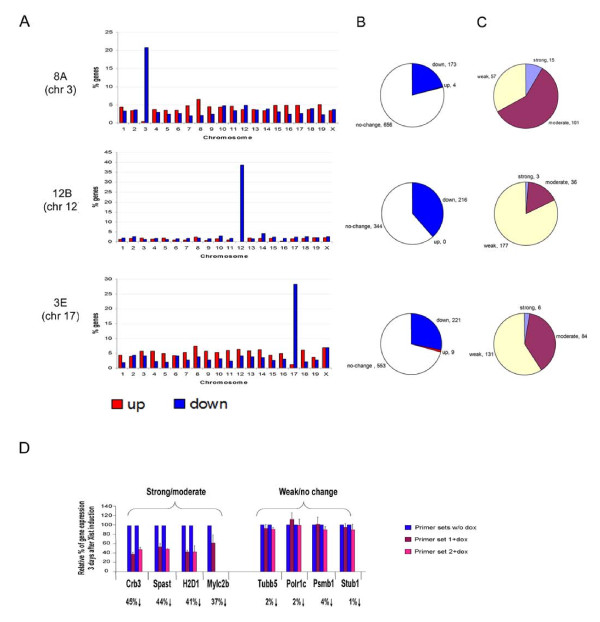
Systematic analysis of gene expression in transgenic embryonic stem (ES) cell lines. (a) The proportion of downregulated (blue) and upregulated (red) genes on all chromosomes following doxycyline treatment of transgenic cell lines as indicated. (b) Pie charts illustrating the proportion of downregulated (blue), upregulated (red) and no change (open) genes on the chromosome carrying the transgene, as indicated. (c) Pie chart illustrating the proportion of downregulated genes showing strong (>50%, blue), moderate (30% to 50%, red) and weak (<30%, yellow) downregulation, as indicated. (d) Quantitative PCR analysis of eight chromosome 17 genes showing strong/moderate or weak/no change in Affymetrix microarray data. Two different primer pairs were used for each gene (except Mylc2b). The average percentage reduction determined for probe sets by microarray analysis is shown below the gene symbols.